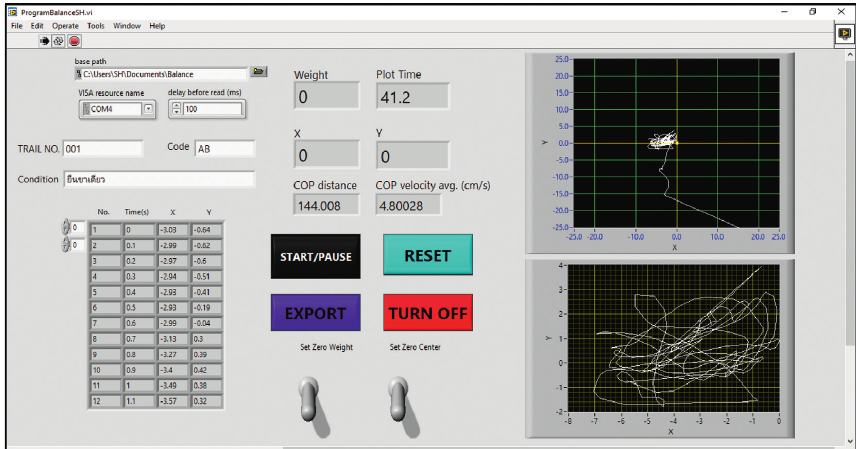
Figure 2: Display of the developed software with